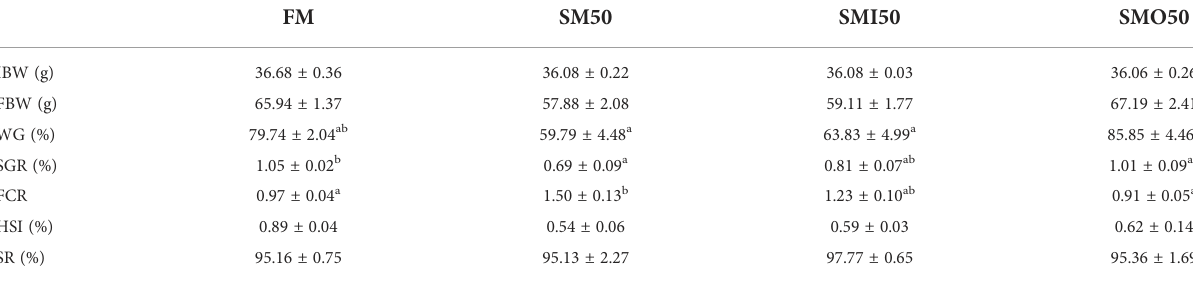
FM (45% crude protein and 12% crude lipid); SM50, by replacing 50% of FM with SM, SMI50, by replacing 50% ofFM with SM and inulin addition; SMO50, by replacing 50% of FM with SMandoligofructoseaddition.Valuesaremeansofthreereplicategroupsandpresentedasmean±SEM.Valuesinthesamerowhavingdifferentlettersaresigni fi cantlydifferent(P<0.05). The lack of superscript letters indicates no signi fi cant difference (P < 0.05) among treatments. IBW, Initial body weight (g); FBW, Final body weight (g); WG, Weight gain = [( fi nal body weight-initial body weight)/initial body weight] × 100 (%);